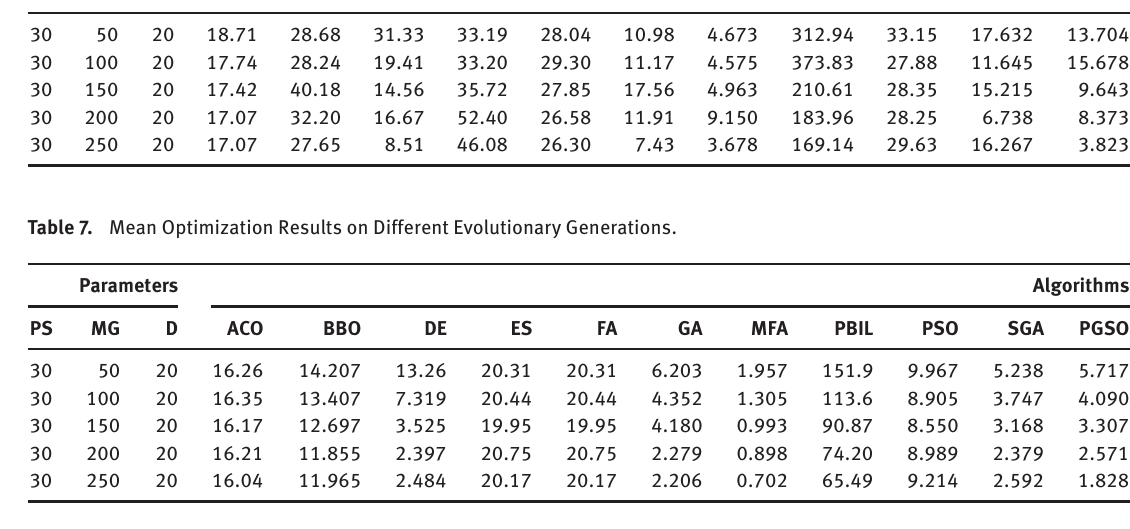
Table 6. Worst Optimization Results on Different Evolutionary Generations. Para meters